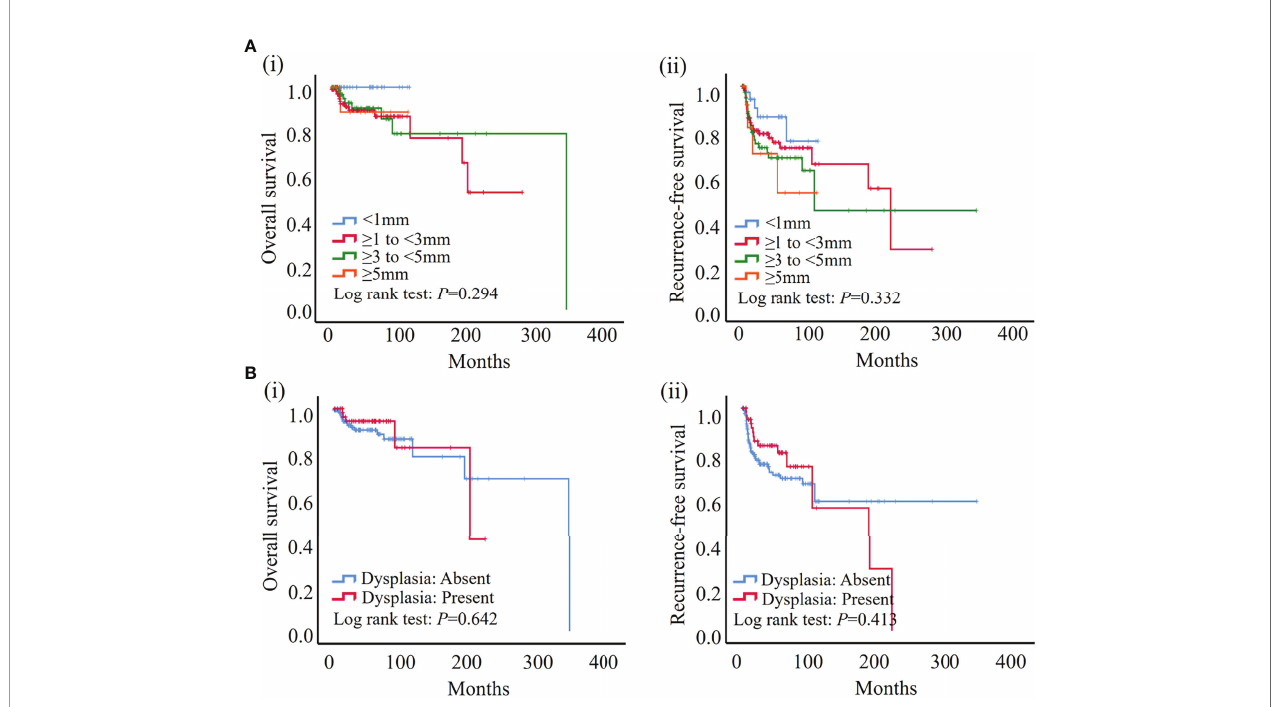
FIGURE 2 | According to the results of the Kaplan – Meier analysis, neither width nor dysplasia was signi fi cantly associated with patient outcome. (A) No signi fi cant association was found between width of surgical margin and both overall (i) and recurrence-free survival (ii) in our cohort. (B) No signi fi cant association was found between dysplasia of surgical margin and both overall (i) and recurrence-free survival (ii) in our cohort.